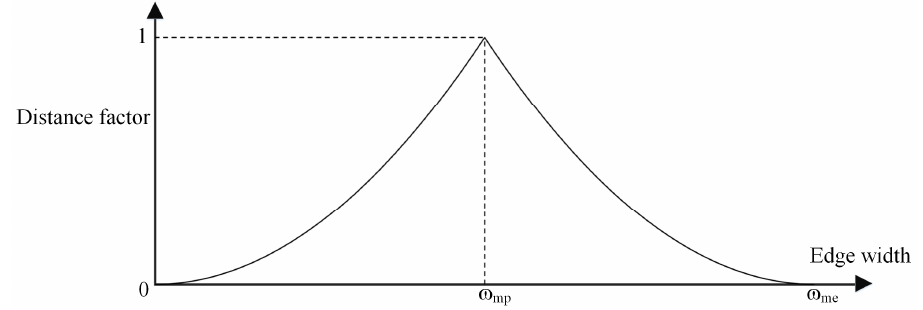
Figure 12. The distance factor variation relationship in Equation (3).